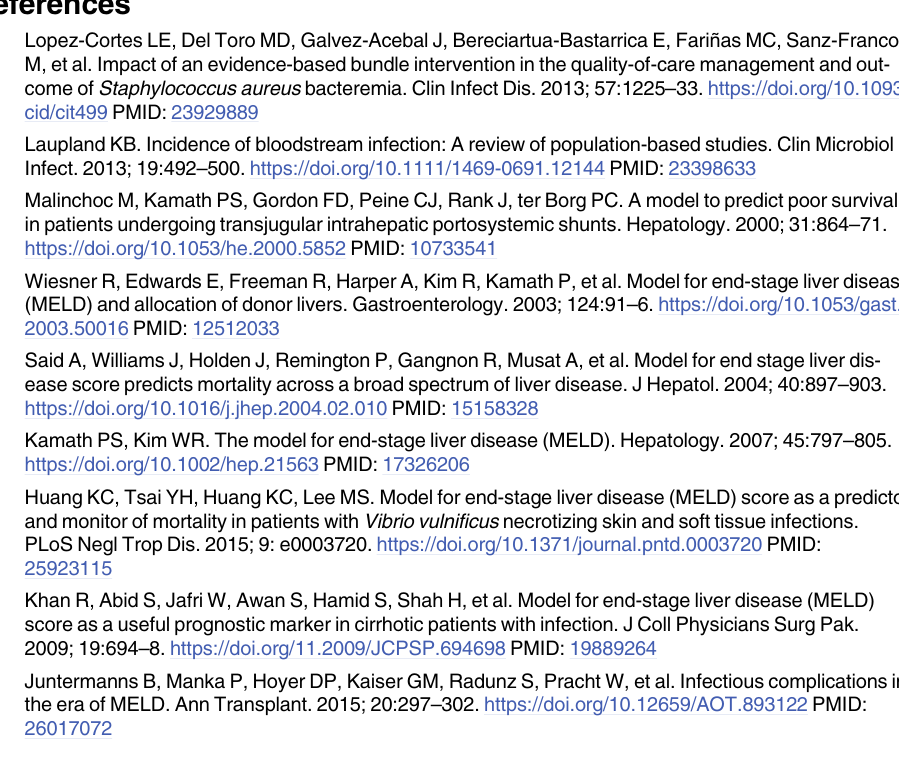
S3 Table. Predictors of In-Hospital All-Cause Mortality in Patients with Staphylococcus aureus Bloodstream Infection (n = 561); Univariable and Multivariable Analyses of the Model for End-Stage Liver Disease Parameters at Bloodstream Infection Onset. S4 Table. Predictors of In-Hospital All-Cause Mortality in Patients with Staphylococcus aureus Bloodstream Infection (n = 561); Univariable and Multivariable Analyses. S5 Table. Comparison of Laboratory Parameters and Mortality in Patients with and with- out Liver Cirrhosis and Concomitant Staphylococcus aureus Bloodstream Infection (n = 555; missing data for six